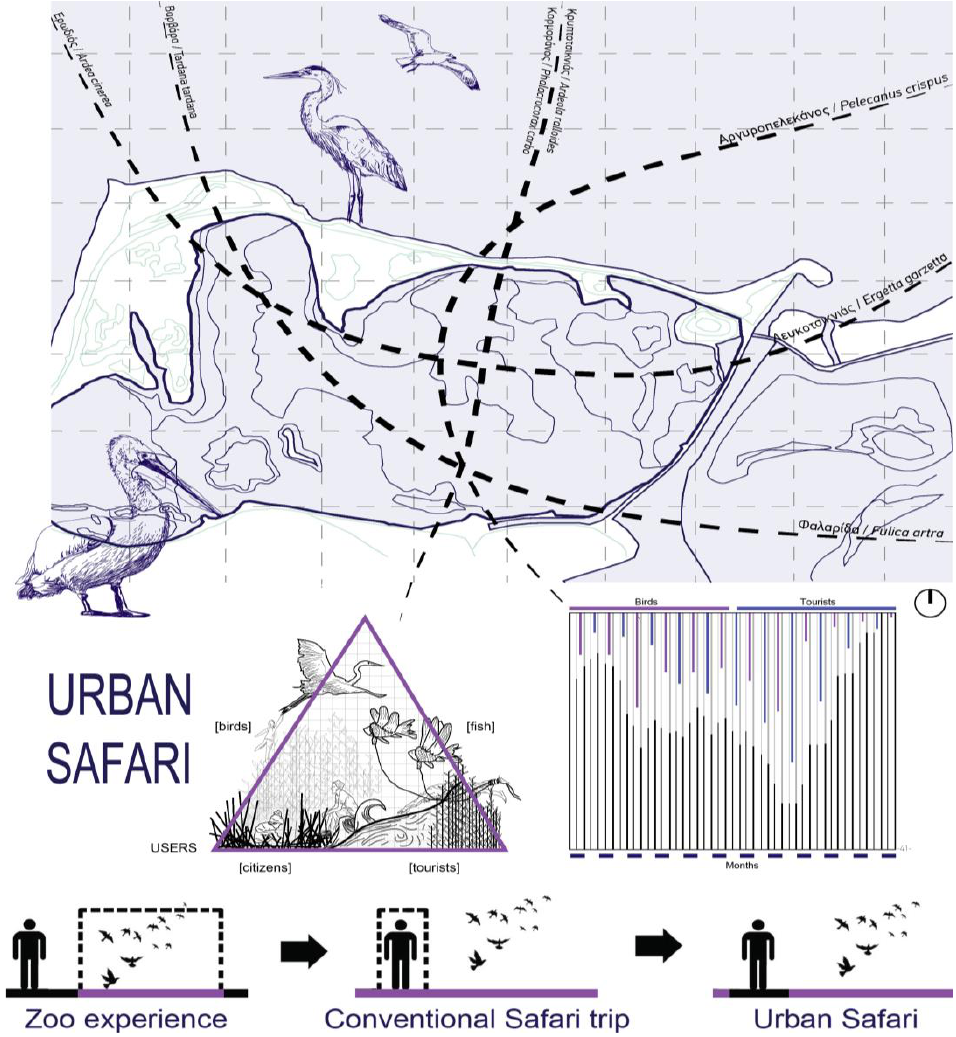
Figure 12. Eleni Kanellopoulou with Karolos Galanos (supervisor), 2022. Urban Safari 38.83, 20.70.